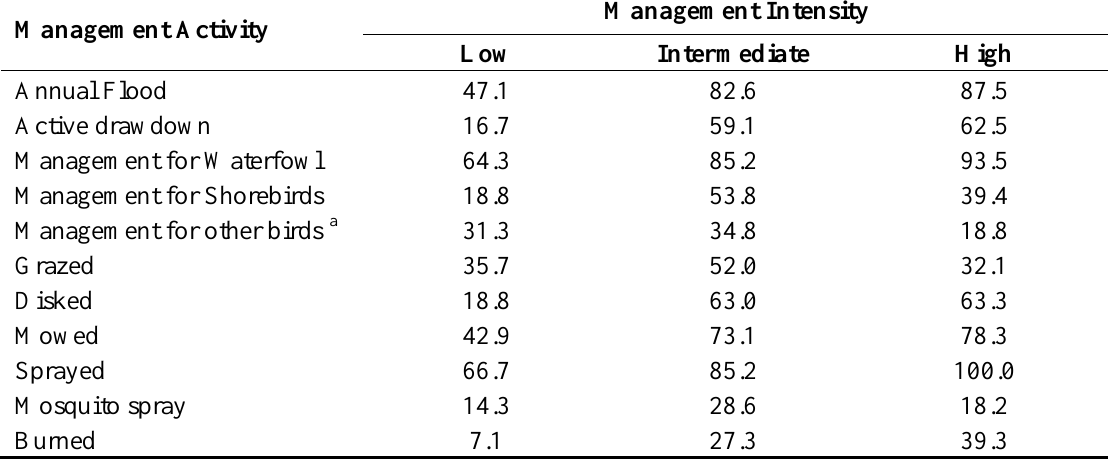
Table 2. Proportion of sites in California’s Central Valley in which specific management activities were applied by management intensity. Management categories are described in Experimental Section. Information was derived from interviews with 77 land owners, managers and NRCS biologists